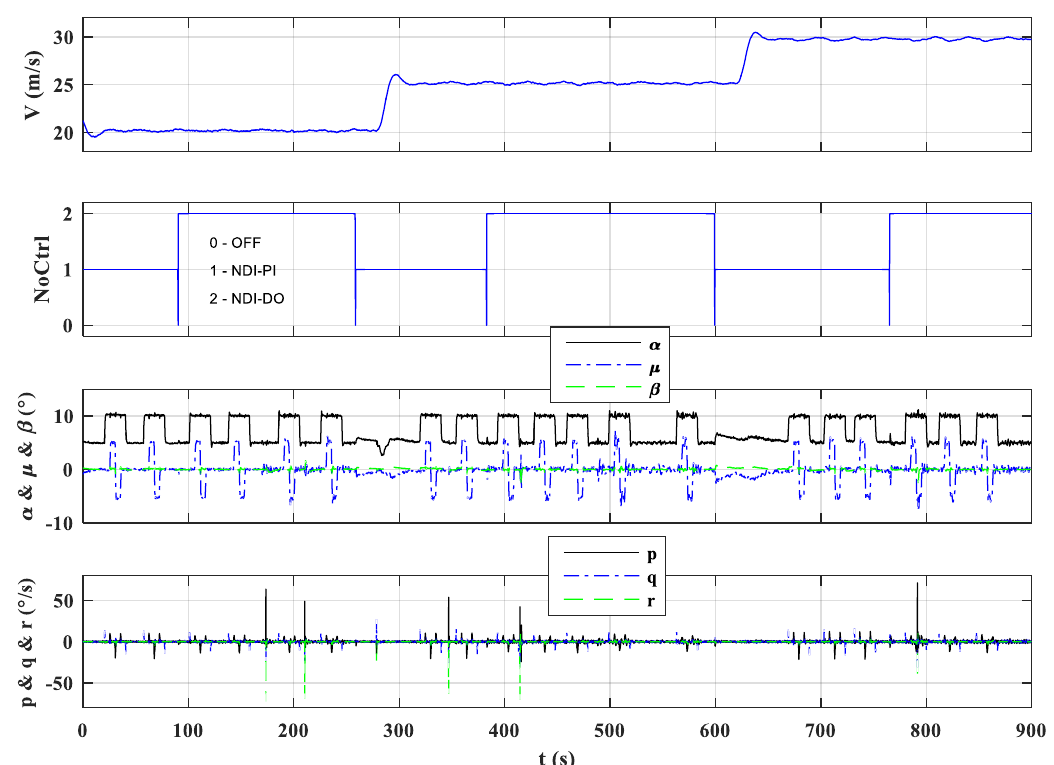
Figure 10. Experimental results of the tailless aircraft model controlled using NDI-PI and NDI-DO in the wind tunnel flight tests.